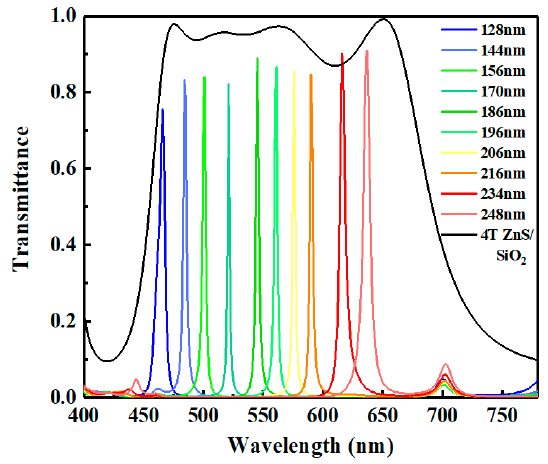
Figure 7. Transmissive spectra of integrated device with different thicknesses of SiO 2 interlayer. Black solid line represents the transmittance curve of the chosen band-pass filter.